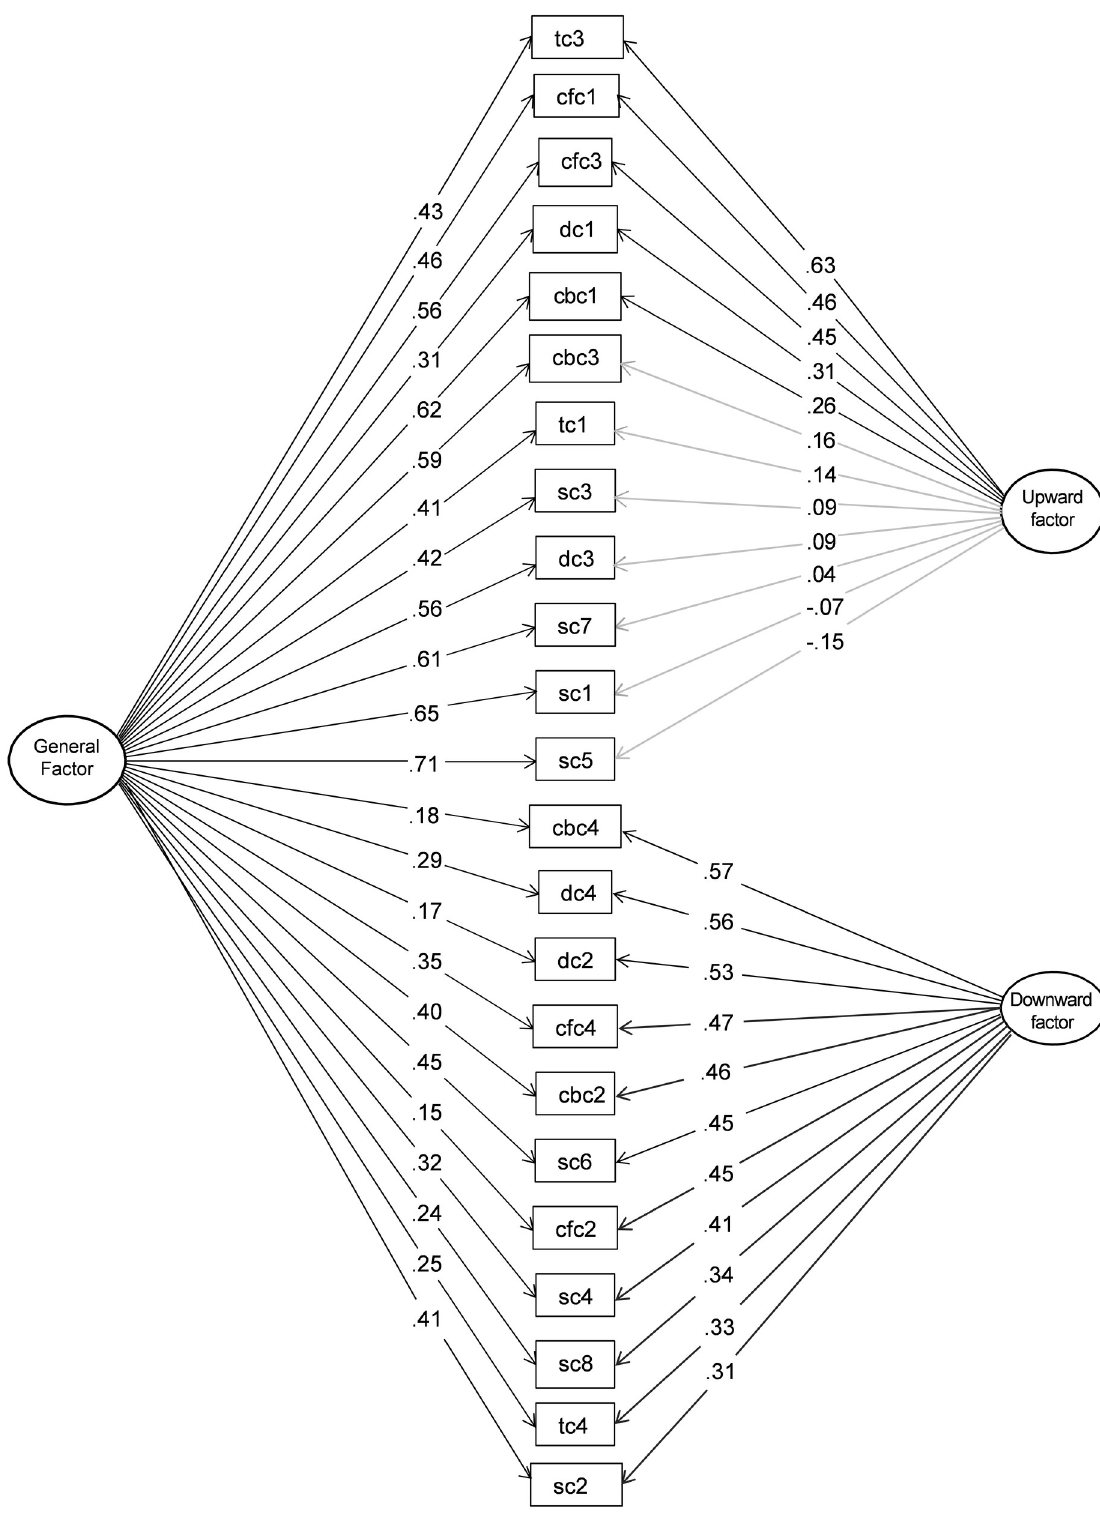
Fig 1. Optimised Bifactor model of comparison direction for the Comparison Standard Scale. Grey lines indicate non-significant loadings. Oddly numbered items address upward comparisons, and evenly numbered items address downward items; SC = Social comparison; TC = Temporal comparison; CBC = Criteria-based comparison; DC = Dimensional comparison; CFC = Counterfactual comparison. https://doi.org/10.1371/journal.pone.0280072.g001 PLOS ONE | https://doi.org/10.1371/journal.pone.0280072 January 11,